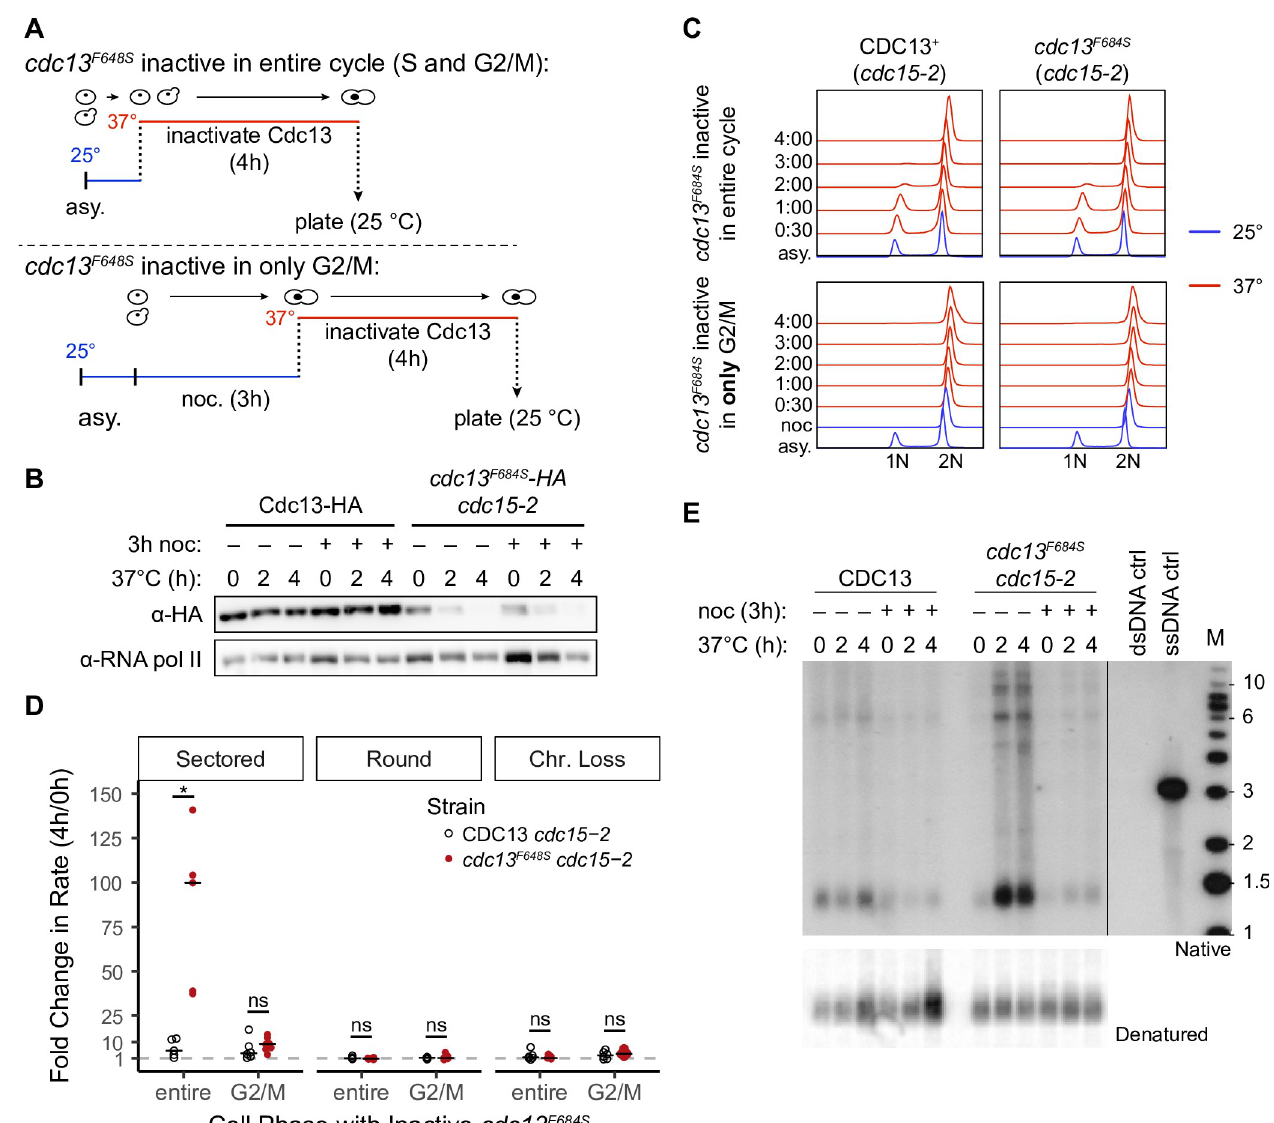
Fig 4. Cdc13 suppresses the formation of unstable chromosomes during S phase. (A) The experimental system to either inactivate or activate cdc13 F684S during S phase. Top : inactive cdc13 F684S for the entire cell cycle, cells were grown to mid-log then incubated at 37˚C for 4 hours. Aliquots for the instability assay were taken at 0h (before the temp. shift) and after 4 hours of incubation at 37˚C. Bottom: inactivate cdc13 F684S in only G2/M, cells were grown to mid- log at 25˚C and then arrested with nocodazole (noc). After noc was washed out, cells were shifted to 37˚C and kept arrested in G2/M with additional noc. Aliquots for the instability assay were taken at 0h (before the temp. shift) and after 4 hours of incubation at 37˚C. (B) Exponentially growing Cdc13-HA or cdc13 F684S -HA cdc15-2 cells were shifted from 25˚C to 37˚C for 2 or 4h. Whole cell extracts were prepared and analyzed by western blot with an anti-HA antibody. Anti-RNA polII was used for a loading control. The–nocodazole (noc) samples were shown in 3B and are shown here for comparison. (C) FACS analysis of DNA content. Cells were grown in liquid YPD as depicted in Fig 4A, and cells were taken at the indicated time points for FACS analysis. Blue traces: 25˚C, red traces: 37˚C. After noc arrest 99% of cells were in G2/M. The time increments refer to time after noc removed and the temperature was shifted. (D) The median fold change in frequency of unstable chromosomes between 4h and 0h (before the temp. shift). The relevant genotypes are as follows: open circles: CDC13 + control ( cdc15-2 ); closed circles: cdc13 F684S ( cdc13 F684S cdc15-2 ). The fold changes were calculated by dividing each 4h frequency by the corresponding 0h frequency for that particular sample (n = 5). The median was then calculated (horizontal bar). The statistical significance between strains per experiment is shown ( � < 0.05; Mann-Whitney U). (E) Non-denaturing in-gel hybridization using a CA oligonucleotide probe with XhoI-digested DNA from the indicated samples ( top ). To control DNA input, the gel was denatured and transferred to a nitrocellulose membrane and hybridized with a telomeric probe ( bottom ).